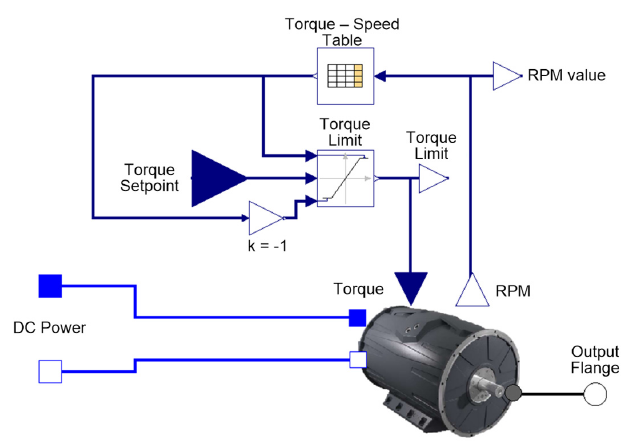
Figure 11. Model of a hybrid Diesel-Battery-Electric Catamarans powertrain developed in Modelica.